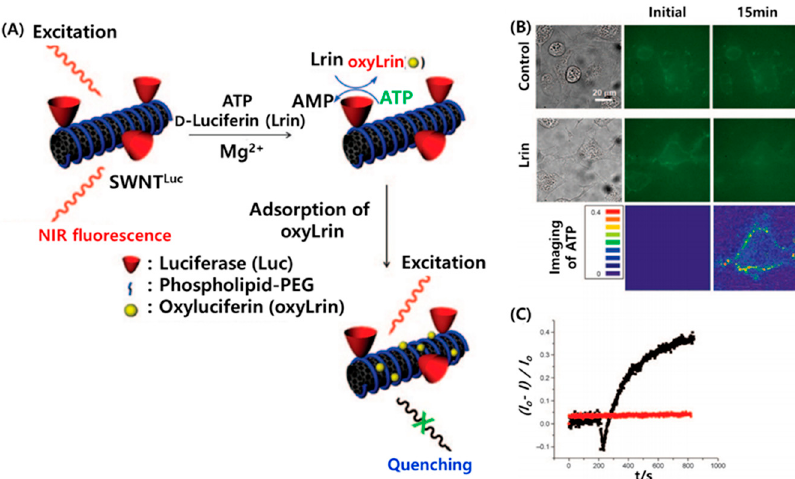
Figure 5. ATP detection in living cells using a SWCNT / luciferase hybrid: ( A ) Schematic description of the SWCNTLuc sensor for cellular ATP detection. The enzymatically oxidized production (oxyLrin) of d-luciferin quenches the NIR fluorescence of SWCNTs. ( B ) NIR fluorescence images of HeLa cells containing the SWCNTLuc sensor with and without addition of Lrin. The NIR fluorescence in HeLa cells is quenched by the addition of Lrin (240 µ M), which is dependent on the ATP concentration. ( C ) Real-time and quantitative tracking of NIR fluorescence of the SWCNTLuc sensor responding to ATP in HeLa cells with (black trace) and without (red trace) addition of Lrin. Reproduced with permission from [35], Copyright @ 2010 WILEY-VCH Verlag GmbH & Co. KGaA, Weinheim (Weinheim,